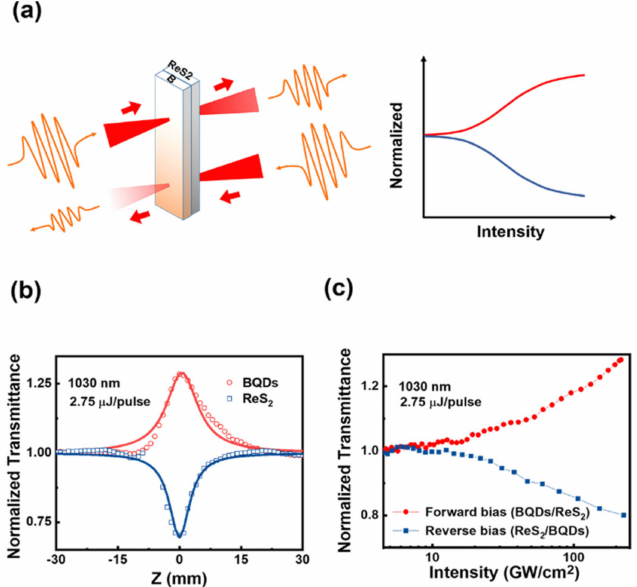
Figure 5. ( a ) action of an all-optical diode based on asymmetric nonlinear absorption (NLA) by employing a BQDs (saturable absorption (SA)) and ReS 2 (reverse saturable absorption (RSA)) in tandem. ( b ) the open aperture z-scan measurement of BQDs and ReS 2 dispersions on 2.75 µ J/pulse at 1030 nm. ( c ) the light transmission in forward bias (BQDs/ReS 2 , red circle) and reverse bias (ReS 2 /BQDs, blue